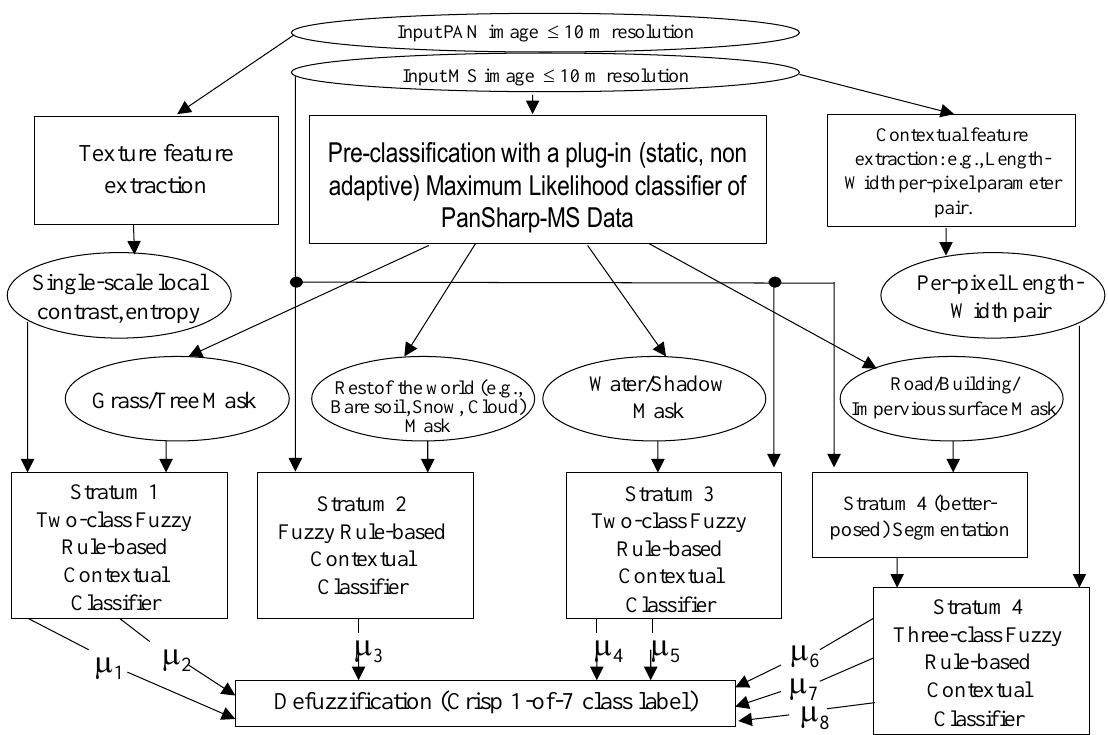
Figure 1. Data flow diagram (DFD) [40], showing processing blocks as rectangles and data derived products as circles, of the Shackelford and Davis stratified hierarchical fuzzy classification approach for high-resolution MS images of urban areas